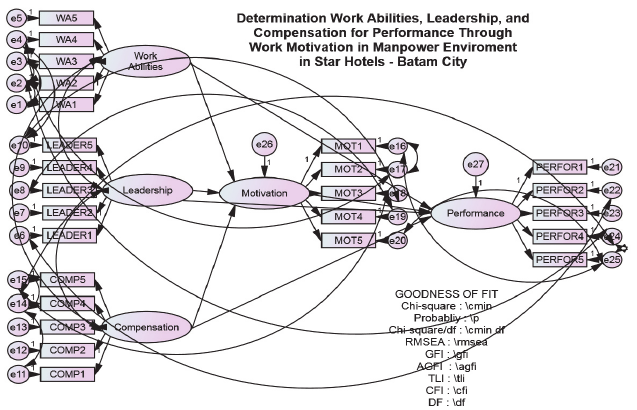
Fig. 2. Comprehensive SEM model (after modifying the